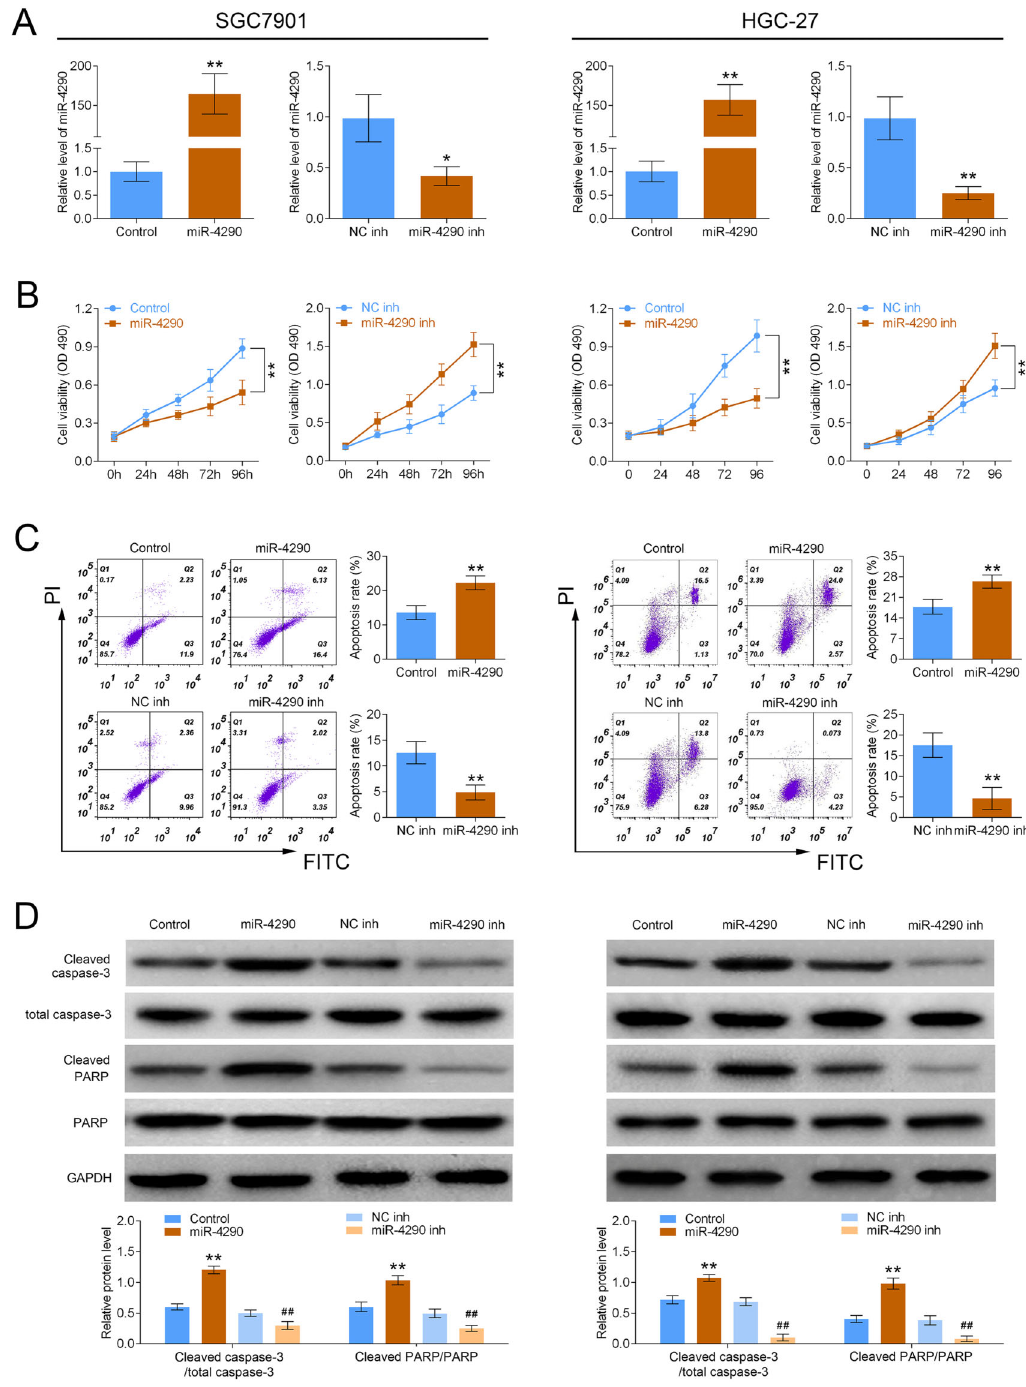
Figure 2. miR-4290 overexpression inhibited cell growth and induced cell apoptosis in gastric cancer (GC). A , The expression of miR- 4290 was detected by RT-PCR assay after SGC7901 and HGC-27 cells were transfected with Control, miR-4290, Negative Control (NC) inh, or miR-4290 inh (n=3, *P o 0.05, **P o 0.01). B , CCK-8 assay was used to detect cell viability (n=3, **P o 0.01). C , Flow cytometry assay was used to detect cell apoptosis (n=3, **P o 0.01). D , The expressions of cleaved caspase-3, total caspase-3, cleaved PARP, and PARP were detected by western blotting assay in SGC7901 cells (left) and HGC-27 cells (right) (n=3, **P o 0.05, compared with Control; ## P o 0.05, compared with NC inh group). Data are reported as means ± SD (ANOVA or t